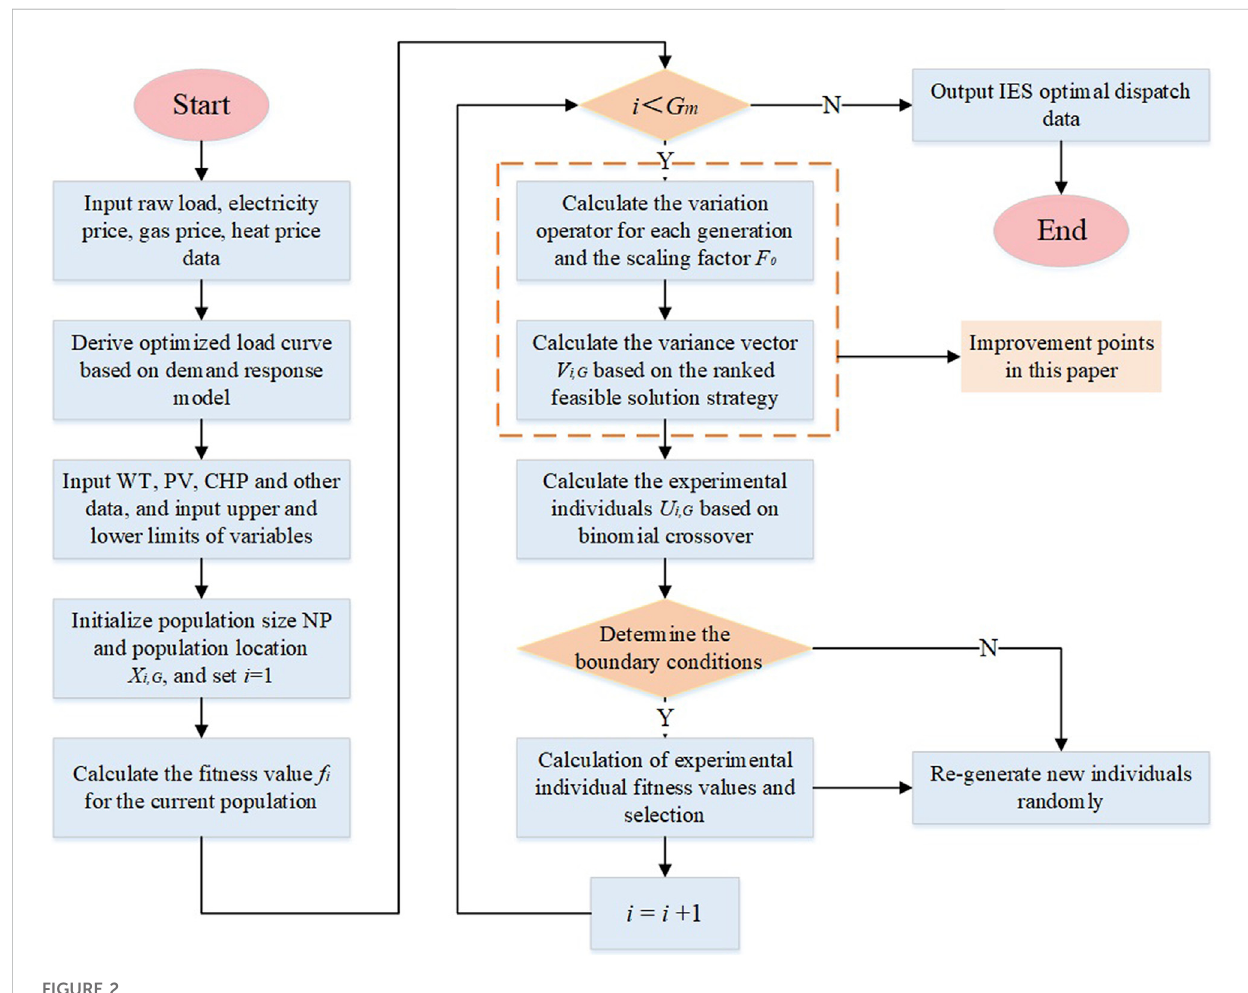
FIGURE 2 Flow chart of improved differential evolution